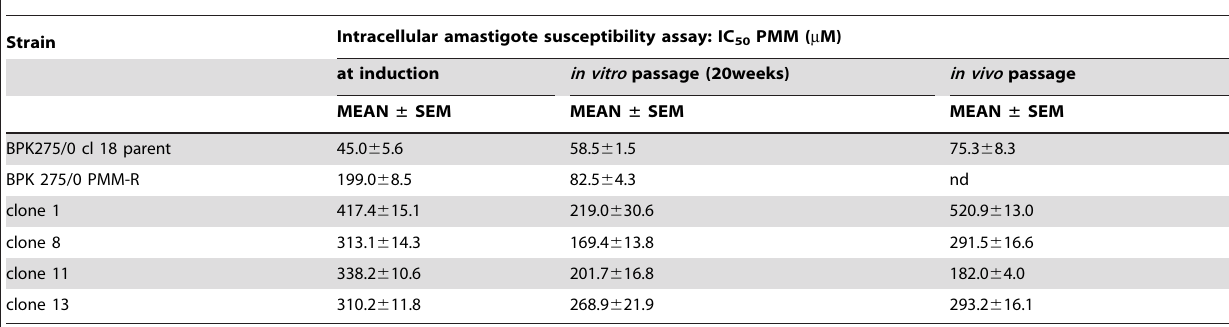
Table 3. S tability of PMM-resistance: in vitro IC 50 after serial passage for 20 weeks as promastigotes or after passage in the hamster and collection of spleen-derived